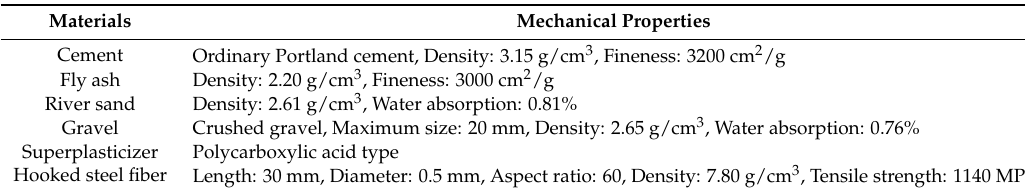
Table 4. Mechanical properties of materials.